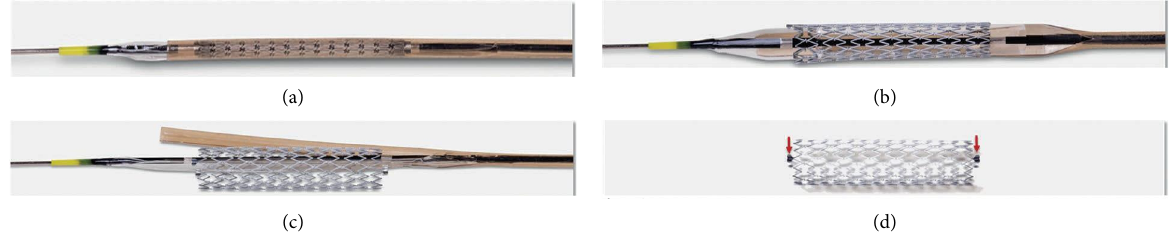
Figure 1: Delivery of self-expanding drug-eluting stent. (a) Stent is mounted on a semi-compliant balloon and is restrained by a splittable sheath. (b) Balloon infation splits the sheath and releases the self-expanding stent. (c) Balloon is then defated, leaving the 0.0032 ″ sheath between the stent and the vessel wall. (d) Balloon and sheath are then withdrawn leaving the stent opposed to the vessel wall. Te two radiopaque stent markers are located at the edges of the stent (red arrows). With permission by STENTYS.